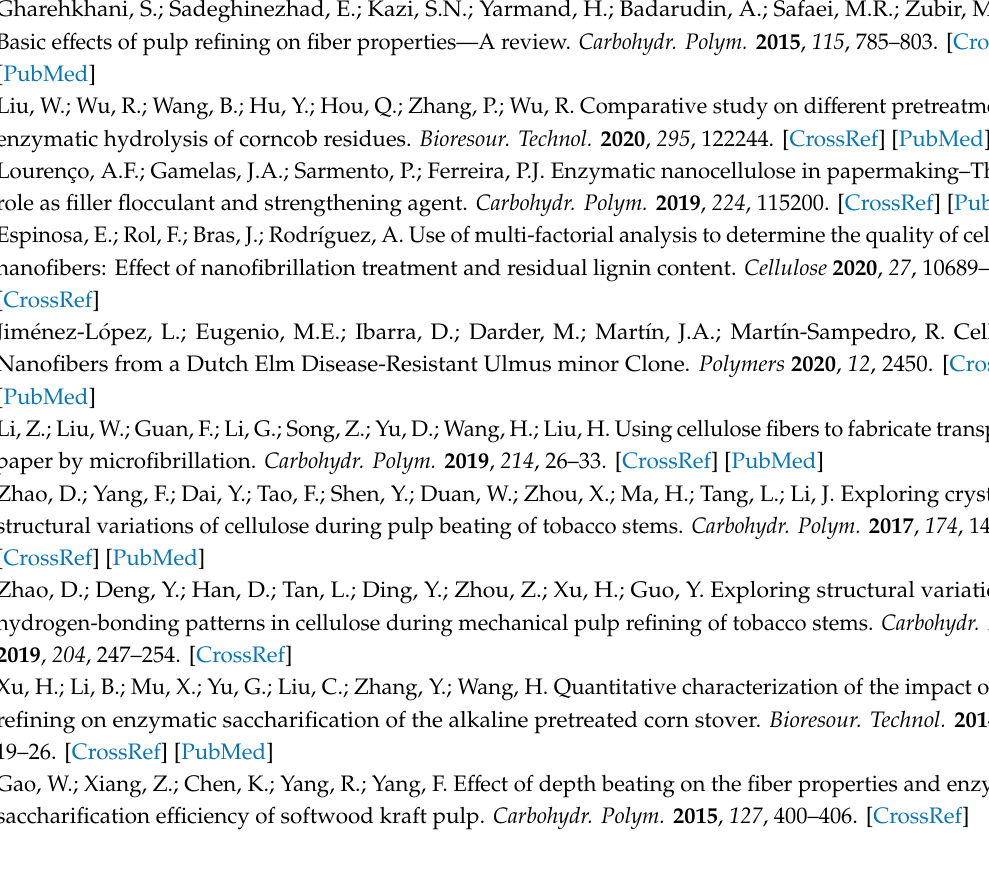
Figure S1: XRD fitting results of softwood fibers: (a) 0, (b) 4000, (c) 8000, (d) 12,000, (e) 16,000 revolutions of PFI refining, Figure S2: XRD fitting results of hardwood fibers: (a) 0, (b) 4000, (c) 8000, (d) 12,000, (e) 16,000 revolutions of PFI refining, Figure S3: Nonlinear fitting curves of the band of hardwood fibers for hydroxyl groups: (a) 0, (b) 4000, (c) 8000, (d) 12,000, (e) 16,000 revolutions of PFI refining, Figure S4: The BET N2 adsorption / desorption isotherms at various refining revolutions of pulp fibers: (a) softwood; (b) hardwood, Table S1: Cumulative pore volume, average pore size and specific surface area of softwood pulp fiber through refining, Cumulative pore volume, average pore size and specific surface area of hardwood pulp fiber through